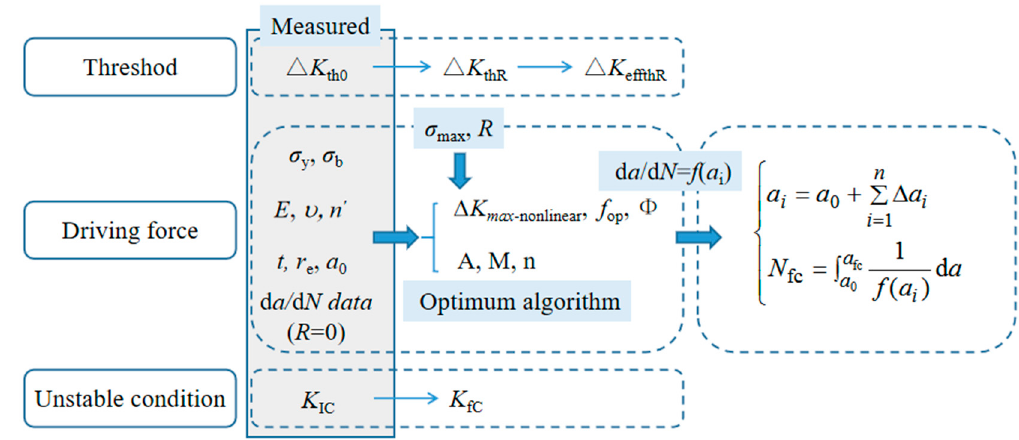
Figure 3. The composition of the unified crack growth rate model.